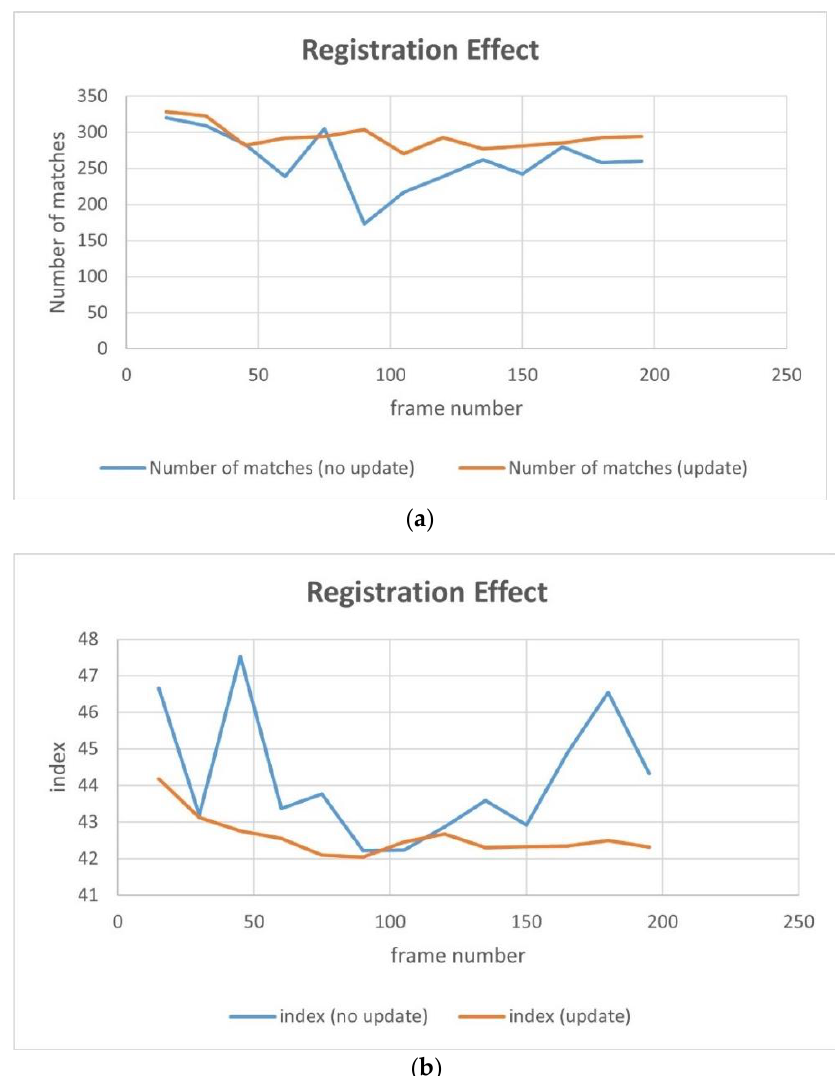
Figure 26. Comparison of the number of matching points and 𝑖𝑛𝑑𝑒𝑥 values : ( a ) number of matches; ( b ) average pixel value of the registered difference image ( 𝑖𝑛𝑑𝑒𝑥 ).